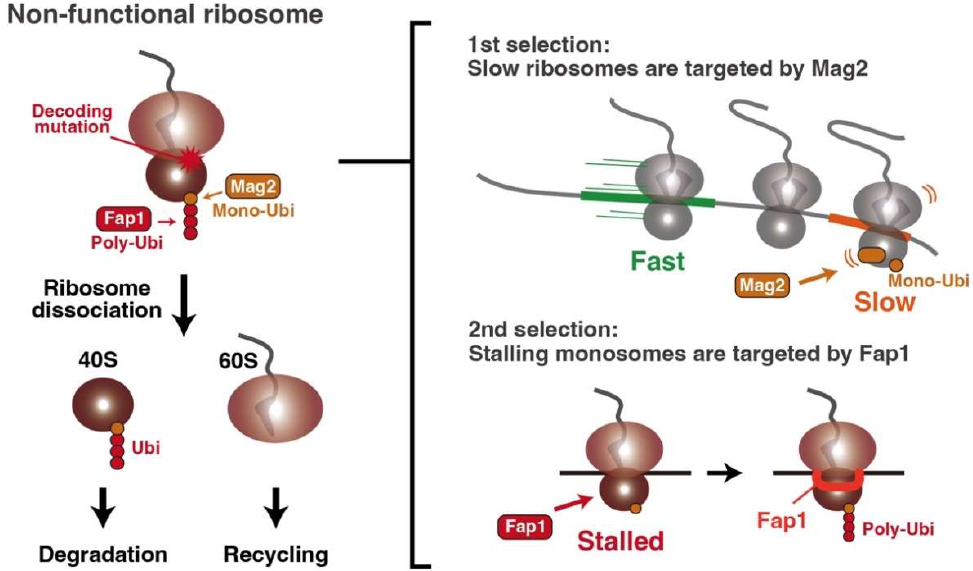
Figure 4. Degradation pathway for the non-functional ribosome. The decoding-defective ribosomes are initially monoubiquitinated by Mag2 and then polyubiquitinated by Fap1 to initiate 18S non- functional rRNA decay (selective degradation of small subunit). In the first selection, Mag2 recognizes the slow translating ribosome and monoubiquitinates ribosomal protein uS3. After the first selection step, Fap1 recognizes stalling monoribosomes and elongates the K63-linked polyubiquitin chain on the Mag2-mediated monoubiquitinated uS3. This tandem ubiquitin system triggers the non-functional 18S rRNA decay.